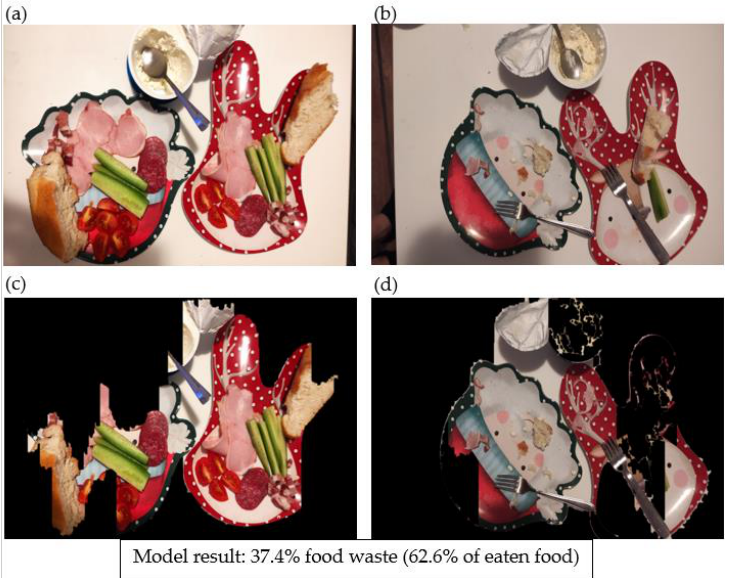
Figure 6. The model deficiency caused by the shape of the plate; ( a ) before the meal, ( b ) after the meal, ( c ) before the meal and masked and ( d ) after the meal and masked. Another deficiency of the model is presented in Figure 7, where the plate has an irregular shape, leading to difficulties in finding the biggest contour and masking the background. The irregular plates caused inadequate food waste detection results, in this case producing the figure of 37.4%.